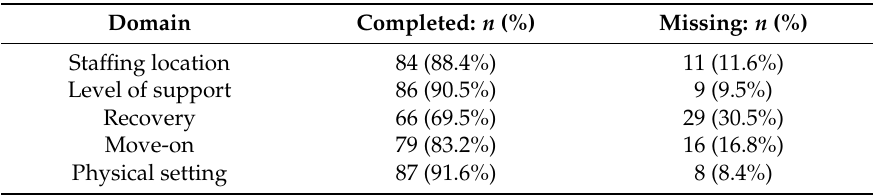
Table 2. Missing data according to domain.